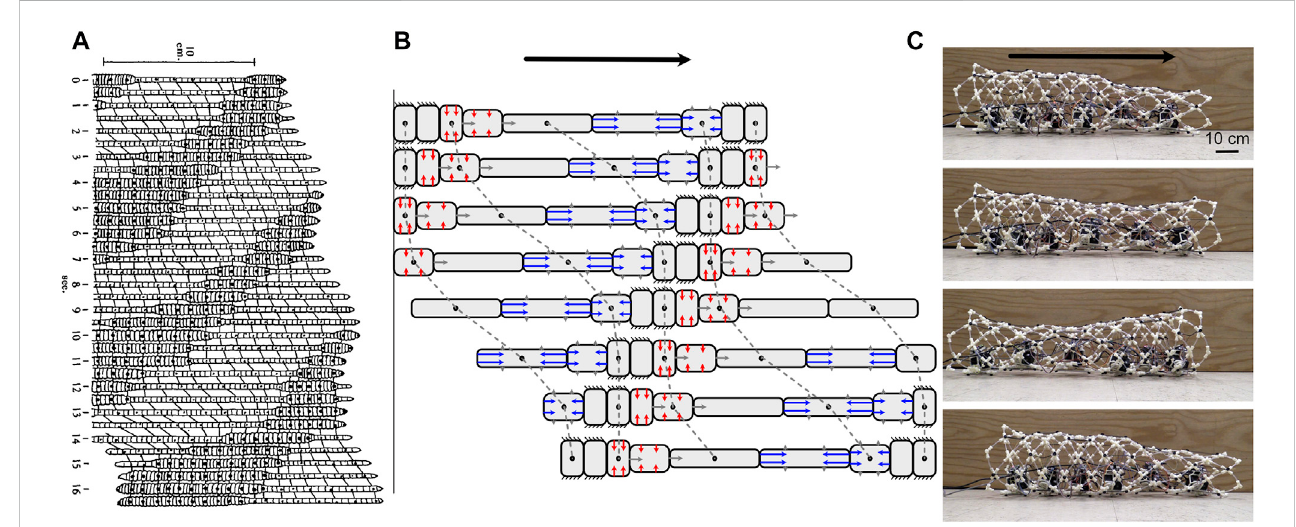
FIGURE 6 (A) Drawing of peristaltic movement by an earthworm showing narrow segments moving and dilated segments anchoring. Reproduced from Gray and Lissman (1938). (B) Diagram of simpli fi ed peristalsis mimicking an earthworm but with fewer segments. Anchored segments are indicated by black lines extending; also shown are segments in which circular muscles (red) are contracting to elongate the segment (against a posterior anchor), and those in which longitudinal muscles (blue) are contracting to shorten the segment (against an anterior anchor). In both diagrams, peristalsis is retrograde (the wave of contraction travels posteriorly), and segments have a constant volume (assuming a cylindrical shape in B). Dots connected with dashed lines show the same segment in multiple frames. (C) These peristaltic motions can be duplicated in robots, as in CMMWorm (images by K.